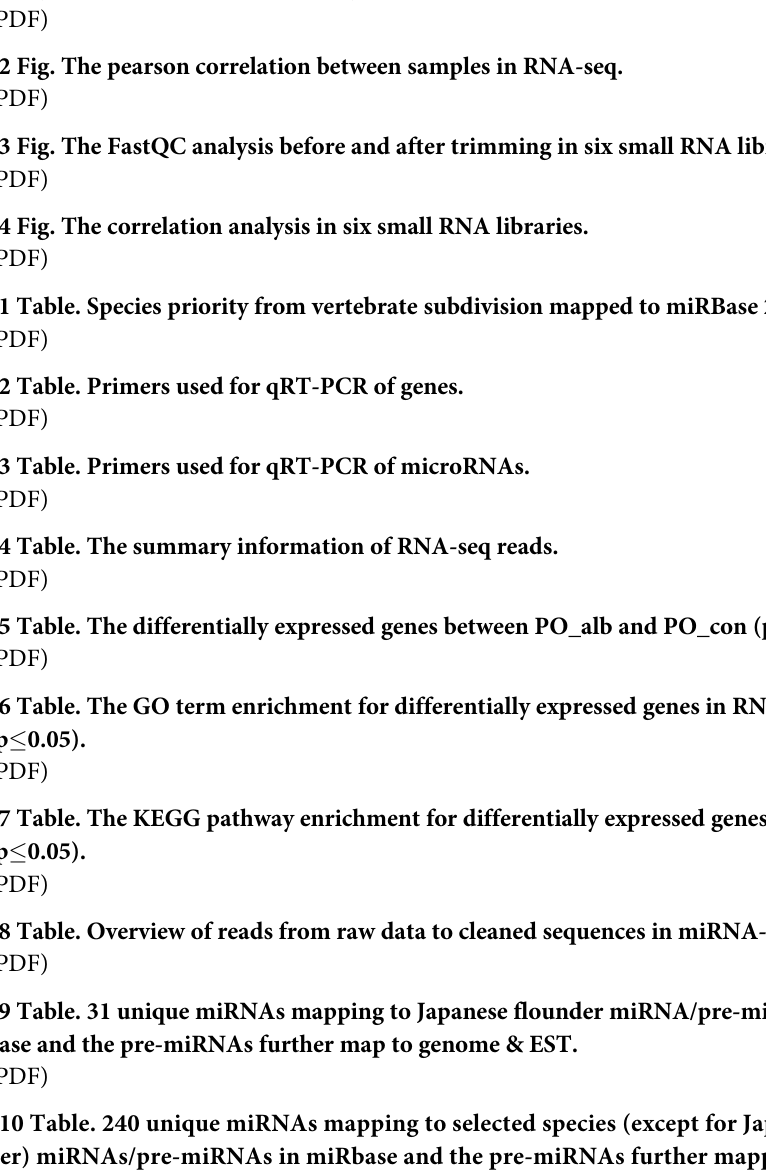
S7 Table. The KEGG pathway enrichment for differentially expressed genes in RNA-seq (p (cid:20) 0.05). S8 Table. Overview of reads from raw data to cleaned sequences in